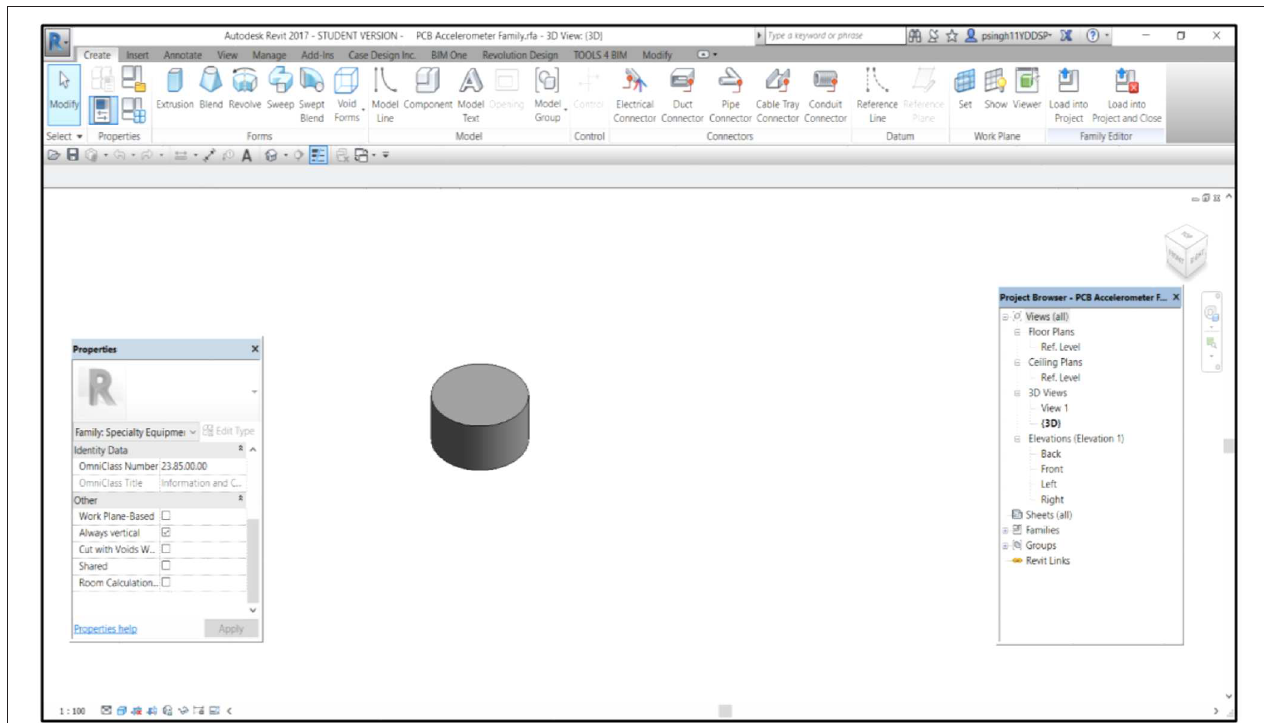
FIGURE 2 | Virtual